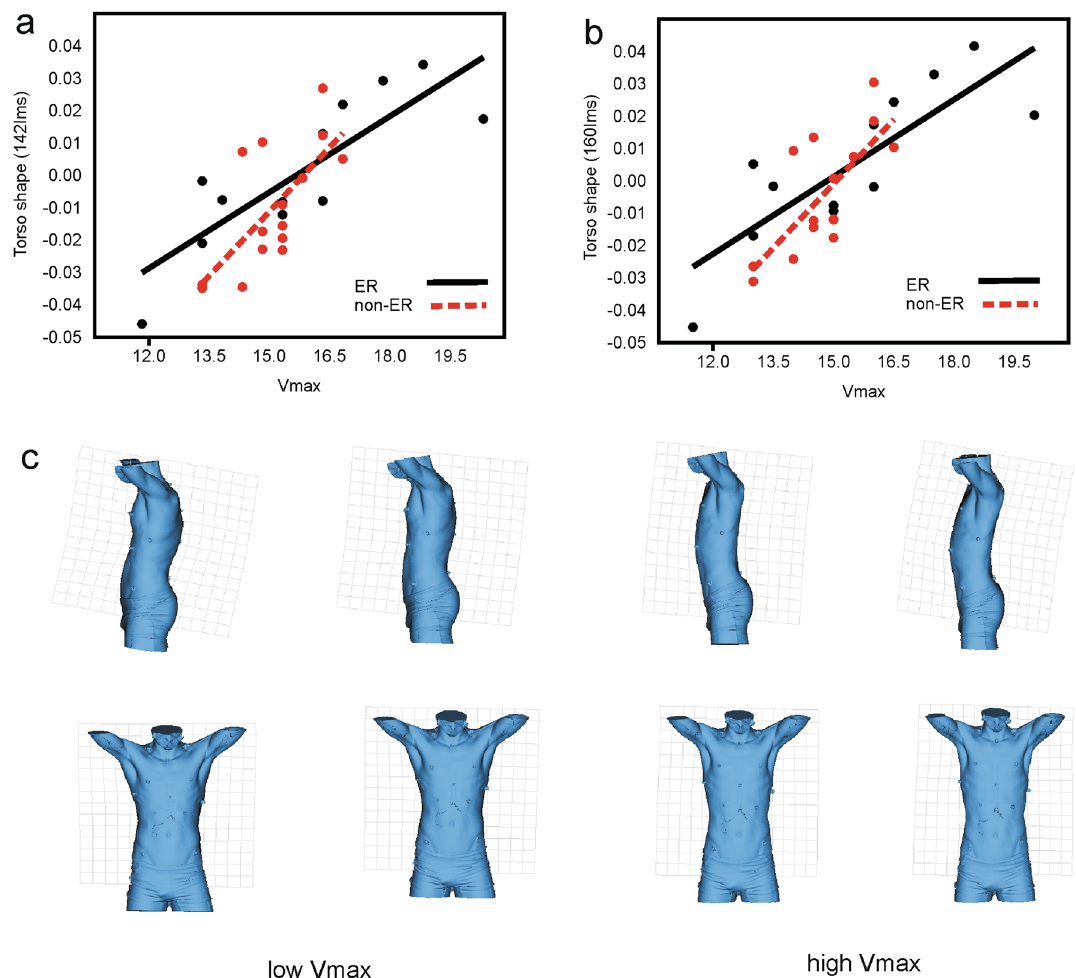
Figure 2. Torso shapes (160 lms) and thin-plate splines warped to the highest and lowest velocity at maximum intensity and running speed. ( a ) Non-muscular torso shape (142 lms) on maximum velocity. ( b ) Full torso shape (160 lms) on maximum velocity ( c ) Full torso shape warped to the configuration of lowest (left) and highest (right) maximum velocities. Upper panel left lateral view, lower panel frontal view. Note that flatter ribcages, narrower trunks with low thoracic kyphosis and more pronounced lumbar lordosis correlate significantly with higher velocities at maximum intensity. (Magnification factor from left to right: − 7.5; − 5; + 5, + 7.5, for better